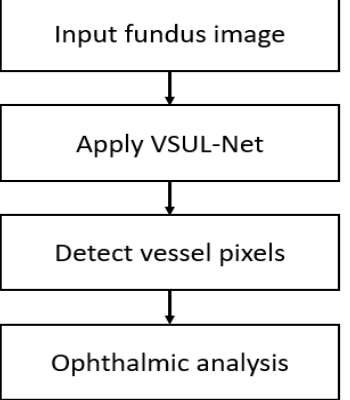
Figure 1. The working overall procedure of the proposed method for vessel segmentation for ophthalmic analysis. Abbreviation: VSUL-Net, vessel segmentation ultra-lite-network.